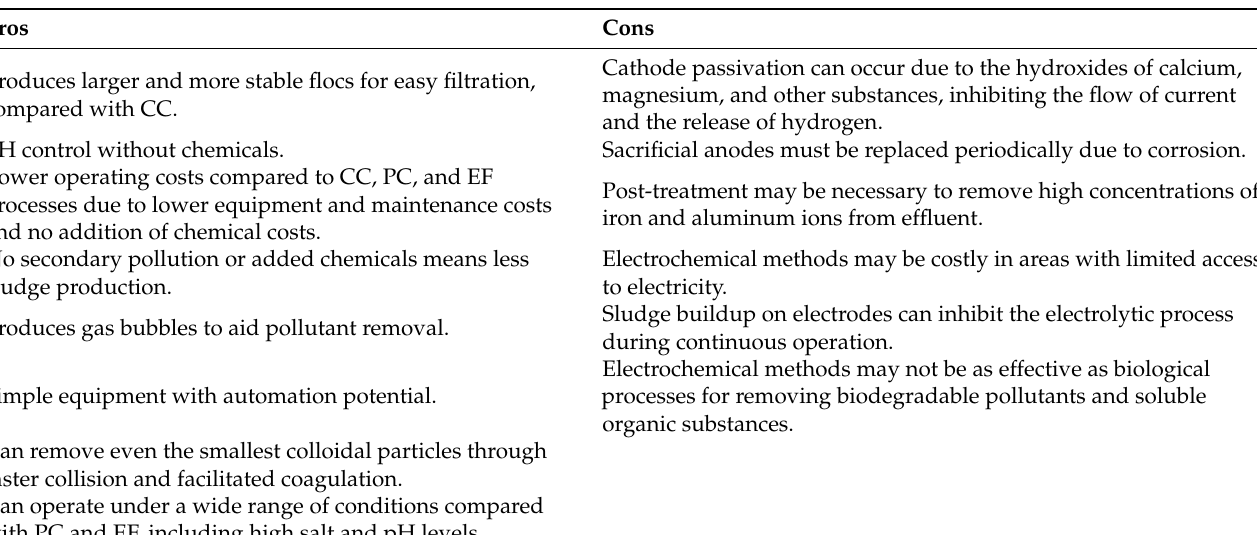
Table 1. Advantages and disadvantages of electrocoagulation over traditional physio-chemical treatment